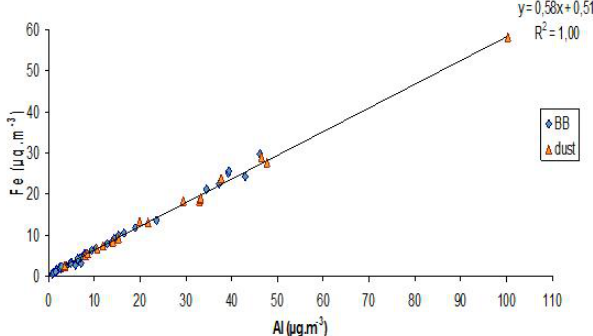
Fig. 2. Plot of Total Fe vs. Kexc in BB samples: two linear rela- tions identified as BB1 group (diamond) and BB2 group (square) are